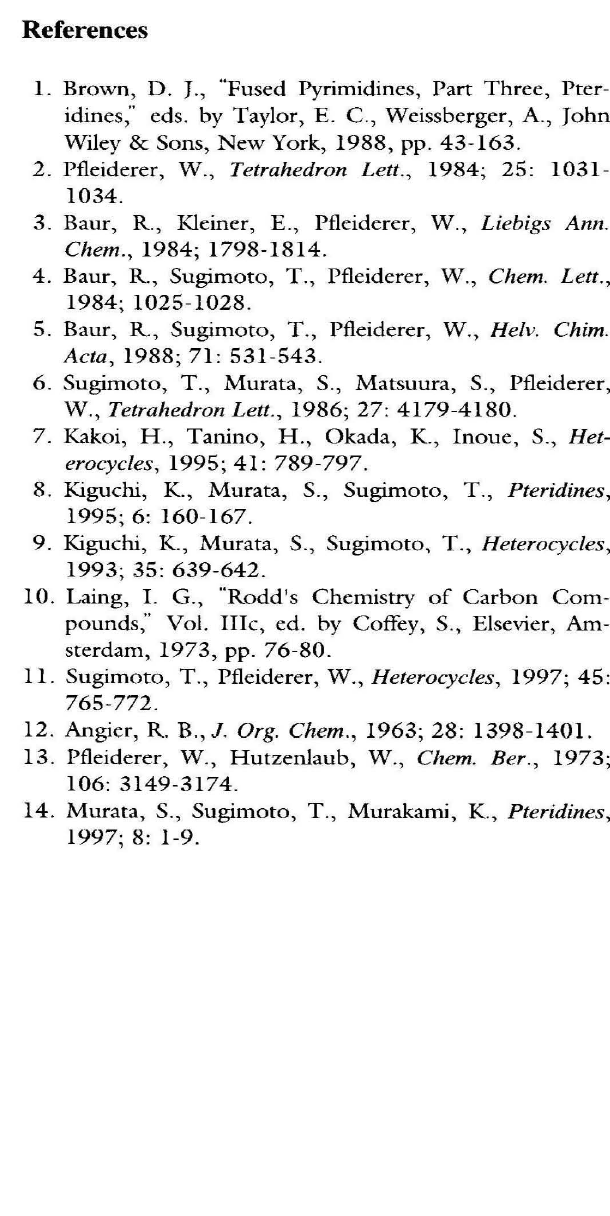
Reduction of Sa into 2a: a general